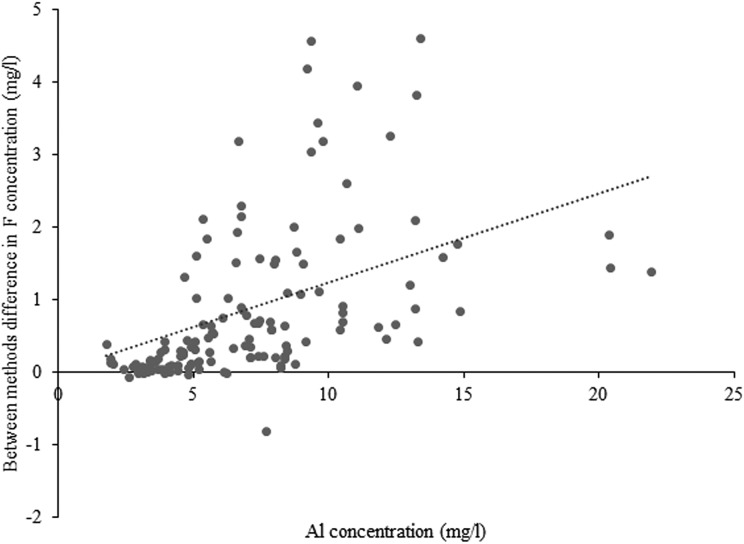
The effect of Al concentration (mg/l) on the difference between measured F concentration (mg/l) using TISAB III and IV. Equation for best-fit line: between-method difference in F concentration (mg/l) = 0.123 × Al concentration (mg/l).